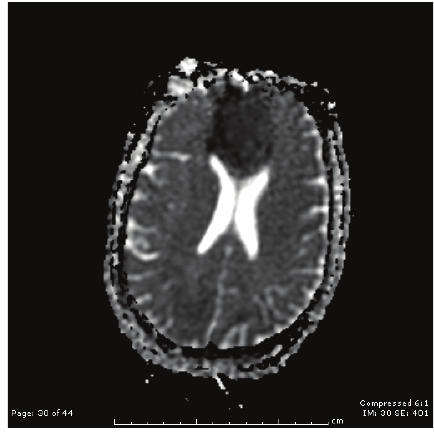
Figure 2: ADC MRI showing mismatch bilateral ACA territory.